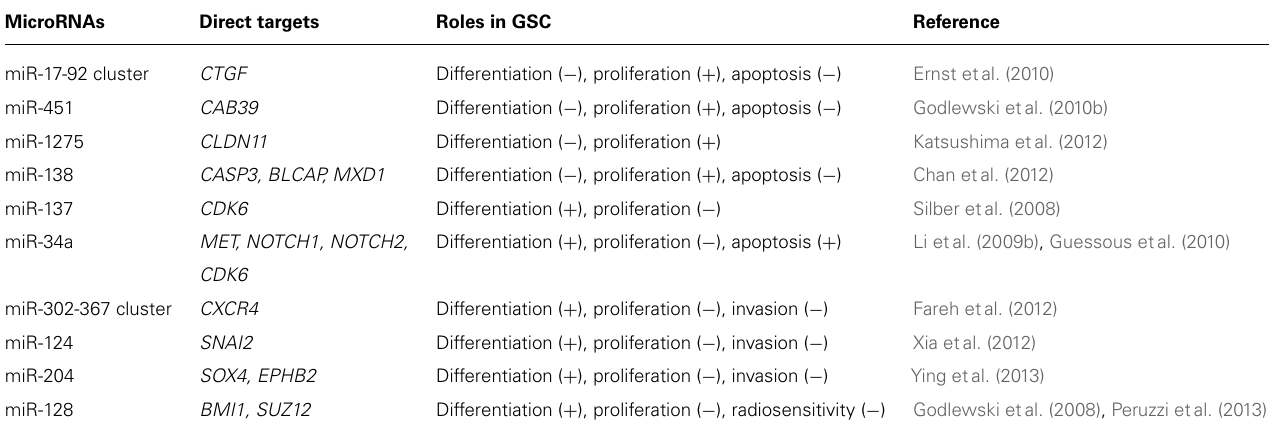
Table 1 | List of miRNAs dysregulated in